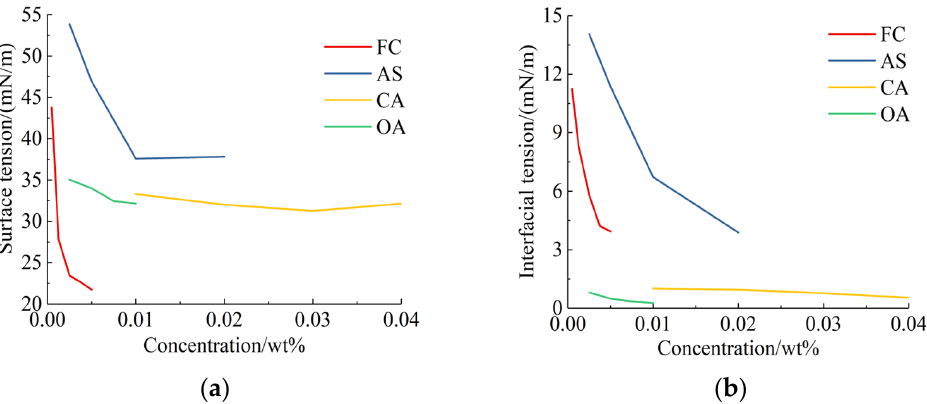
Figure 1. Surface/interfacial tensions of four surfactants. ( a ) Surface tension; ( b ) interfacial tension. Amphoteric ionic surfactant CA had a good ability to reduce the interfacial tension. When its concentration was 0.01 wt%, the interfacial tension between its aqueous solution and tight oil decreased to 1.0 mN/m. Its ability to reduce surface tension increased when its concentration was increased; when its concentration was less than 0.03 wt%, the minimum interfacial tension observed was 32.1 mN/m. When its concentration was greater than 0.03 wt%, its surface tension showed a slight increasing trend. However, both the surface tension and the interfacial tension of amphoteric surfactant CA aqueous solution generally showed a relatively stable distribution with its concentration increas ‐ ing. The surface tension of anionic surfactant AS aqueous solution decreased rapidly with an increase in its concentration. When its concentration was 0.01 wt%, the surface tension of its aqueous solution decreased to 37.0 mN/m. As its concentration continually increased, the surface tension basically remained stable, but its ability to reduce the in ‐ terfacial tension increased with its concentration increasing, to a minimum of 3.88 mN/m. 4.4. Oil–Displacement Agent for Energy Storage Fracturing According to the surface/interfacial tension evaluation of the surfactants, fluoro ‐ carbon surfactant FC could significantly reduce the surface tension, and both amphoteric surfactants CA and OA had a good ability to reduce the interfacial tension. Meanwhile, anionic surfactant AS’s negative charge with the tight sandstone core’s negative charge meant that the anionic surfactant could effectively reduce the adsorption of surfactants on the rock. Based on the performed experiments, two oil displacement compositions were proposed for the following studies, and they are shown in Table 2. Table 2. Formulas of oil–displacement agents. FC/wt%